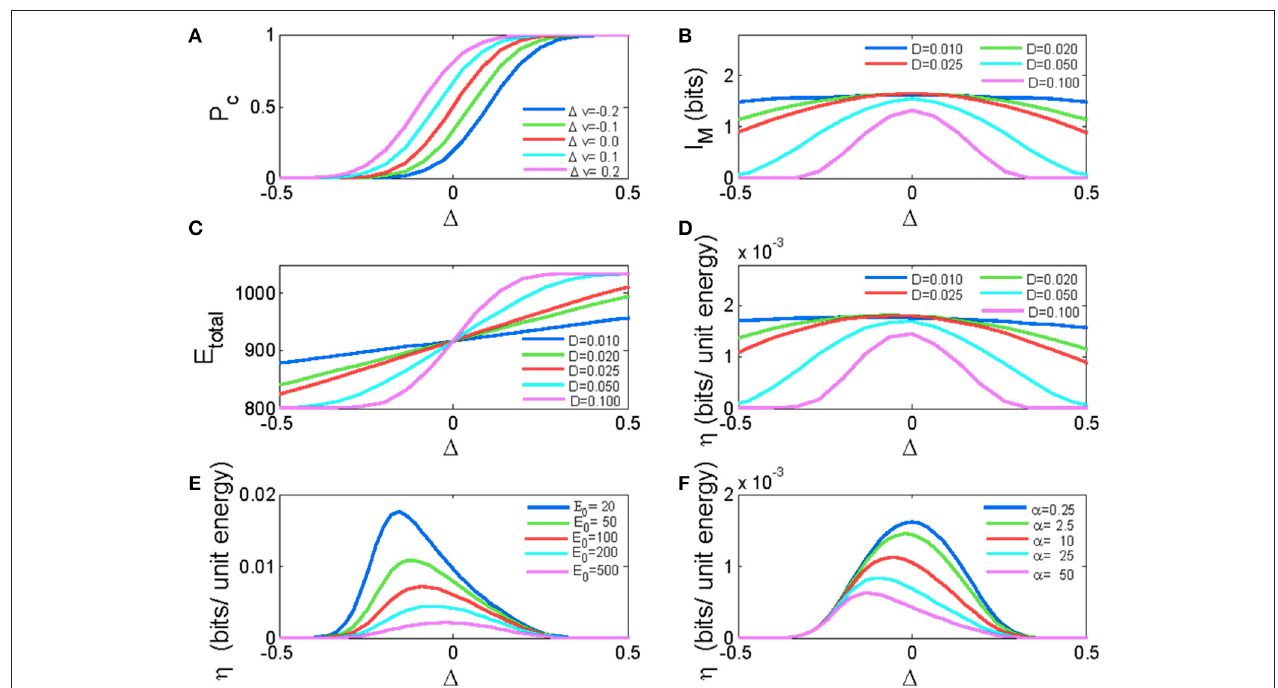
FIGURE 6 | The analytic solution for a bistable neuron network. (A) The dependence of the pulse signal detection rate on the net synaptic current for different input signal strengths. D 0.1; (B) The mutual information of a bistable neuron network as a function of the net synaptic current for different noise intensities. (C) The total = energy cost of a neuronal network as a function of the net synaptic current for different noise intensities. (D) The energy efficiency as a function of the net synaptic current for different noise intensities E-0 24. (E) The energy efficiency as a function of the net synaptic current for different fixed energy costs. (F) The energy = efficiency as a function of the net synaptic current for different energy costs per synaptic event. In these calculations, N